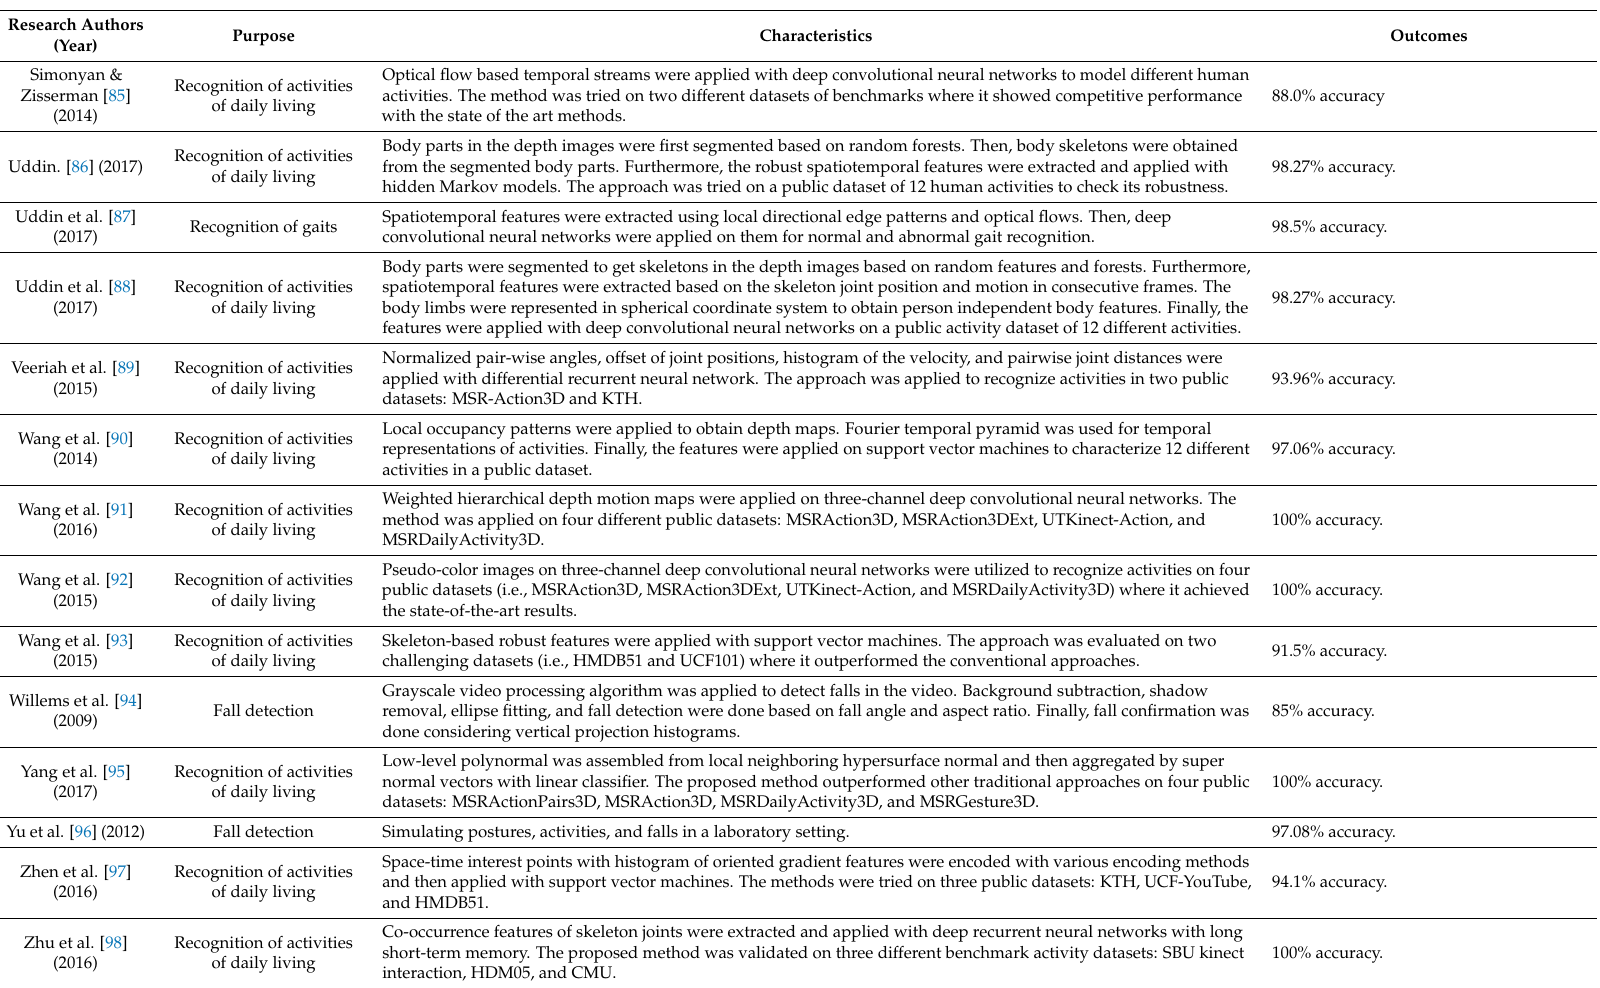
Table 3. Summary of research works that use video sensor